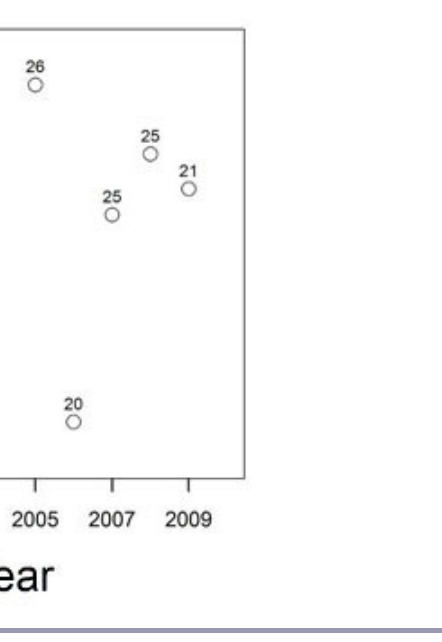
Fig. 1. Number of swifts counted at roost sites in the province of Québec between July 25 and August 3. Yearly numbers were obtained by adding the number of swifts counted at each roost sampled during that year. Numbers located over circles represent the number of roosts sampled. Data from 2001 to 2004 are not illustrated because the sample size during those years was low (N < 10) and/or omitted some major roost sites (i.e., roosts where ‡ 200 swifts had previously been recorded). All sampled sites were located within the inhabited portion of Québec, i.e., from the Gaspé Peninsula in the east, to Shawville in the west, and from La Tuque in the north (excluding the Gaspé Peninsula), to Huntingdon in the south, where the majority of roost sites are located. Because counts were conducted during migration and the vast majority of swifts likely use roost sites during migration, we are confident that our sample sizes are representative of the Québec swift